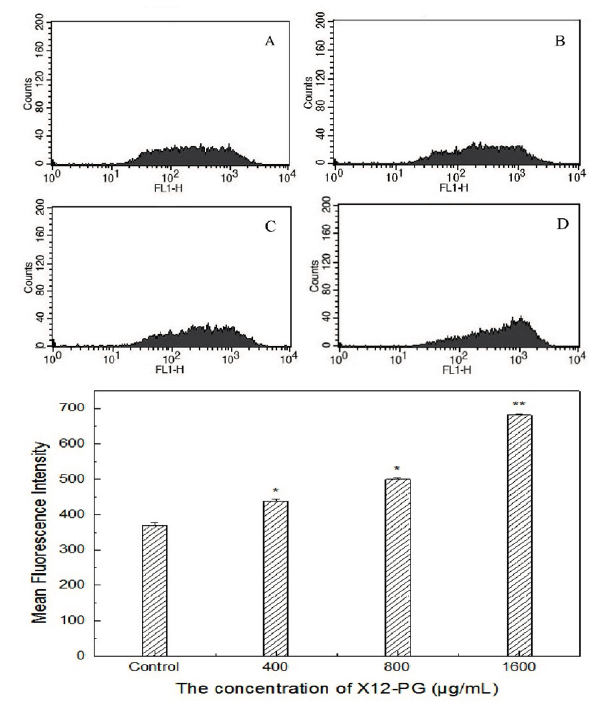
Figure 7. Intracellular Ca 2+ concentration ([Ca 2+ ]) after treatment of X12-PG. ( A – D ) were respectively treated with 0, 400, 800, 1600 μ g/mL X12-PG for 48 h. Cytosolic [Ca 2+ ] was increased in a dose-dependent manner after exposure to X12-PG. HT-29 cells were loaded with Fluo-3/AM and analyzed by flow cytometry. Fluo-3/AM was excited at the 488 nm line of an argon laser and the fluorescence intensity was measured at an emission wavelength 530 nm. [Ca 2+ ] was expressed as mean fluorescence intensity (MFI). (Error bars are mean ± SD, * p < 0.05 versus control, ** p < 0.01 versus